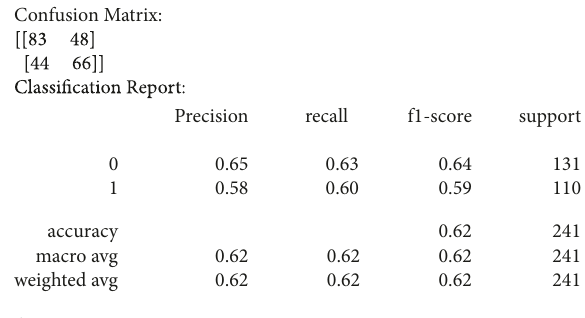
Figure 8: GNB confusion matrix, classification report, and